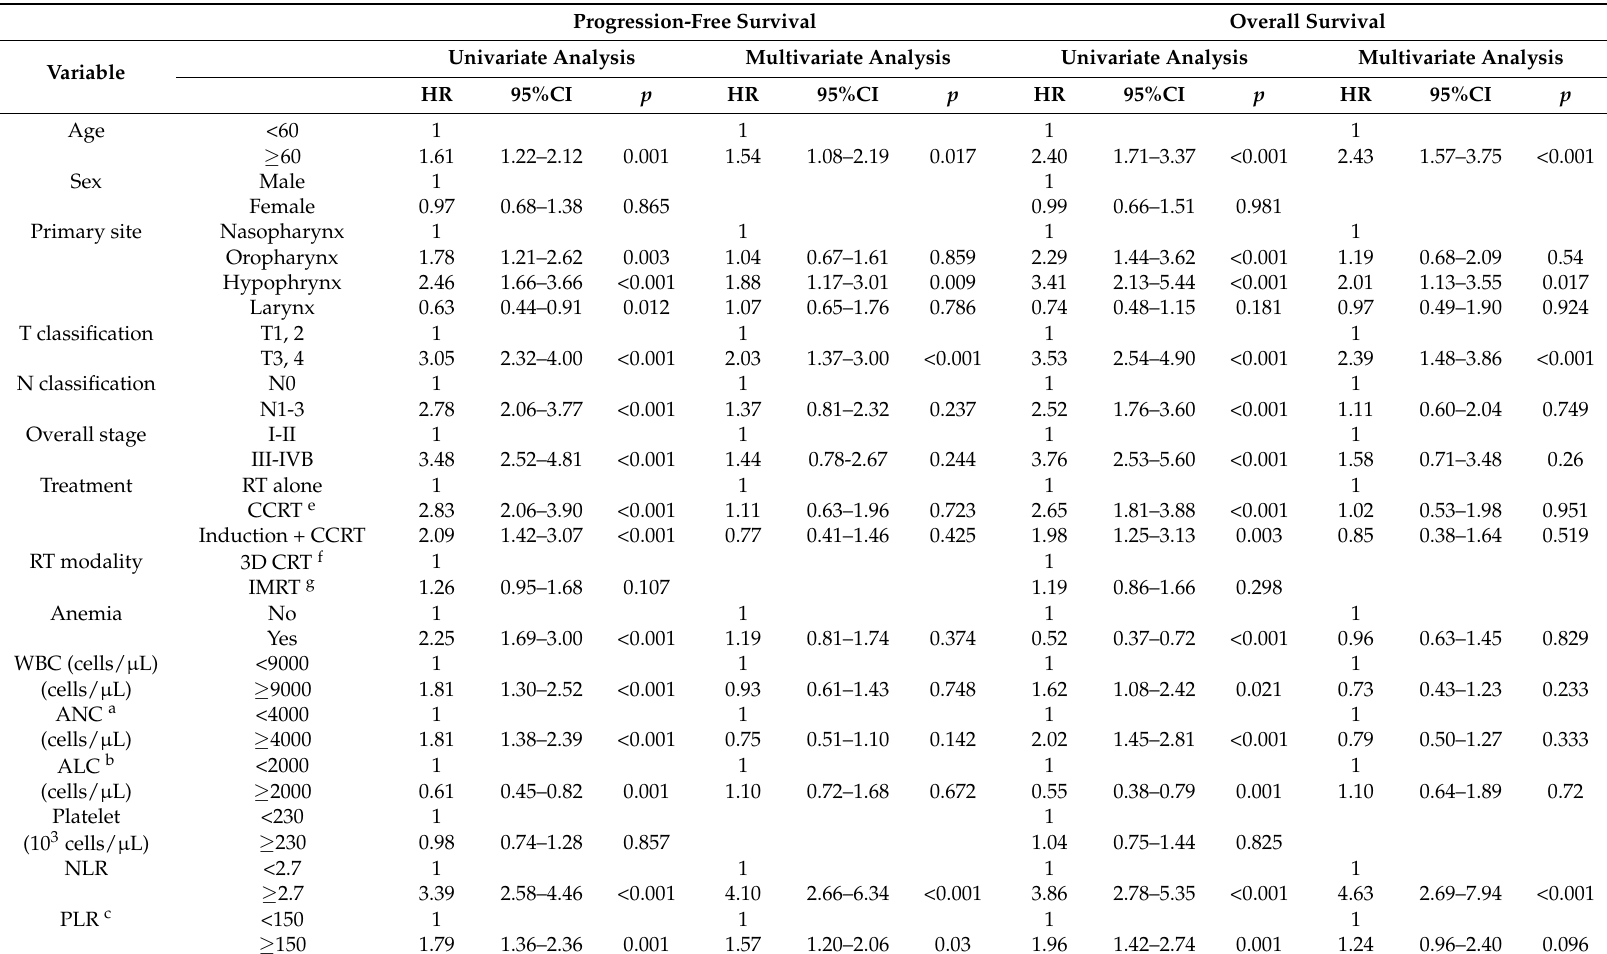
Table 3. Prognostic factors for progression-free survival and overall